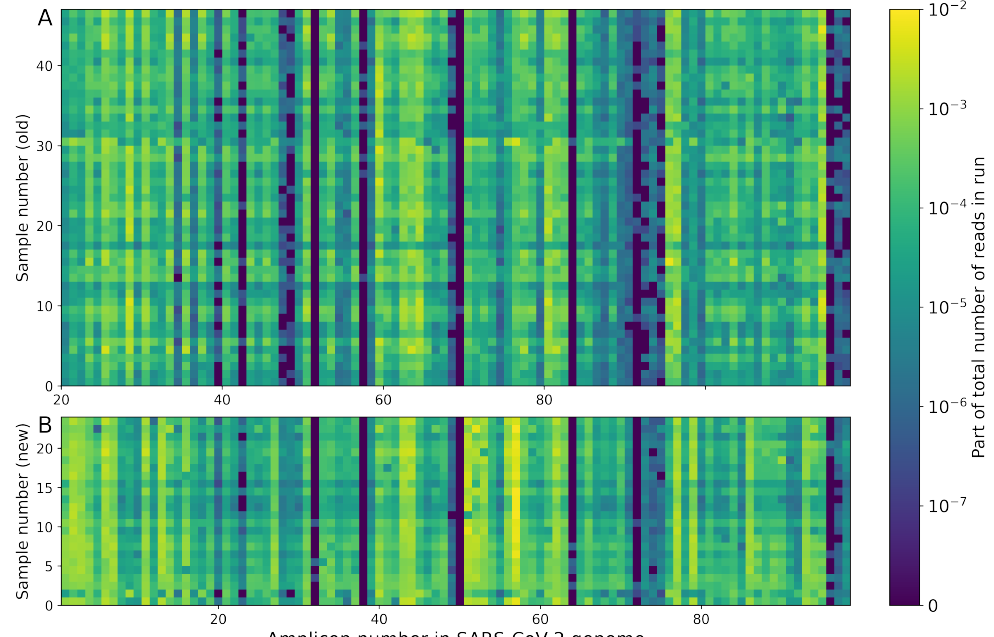
Figure 5. Coverage rates for 98 target regions of SARS-CoV-2 whole genome. Two series of 47 and 24 samples are presented for old ( A ) and new ( B ) poolings,